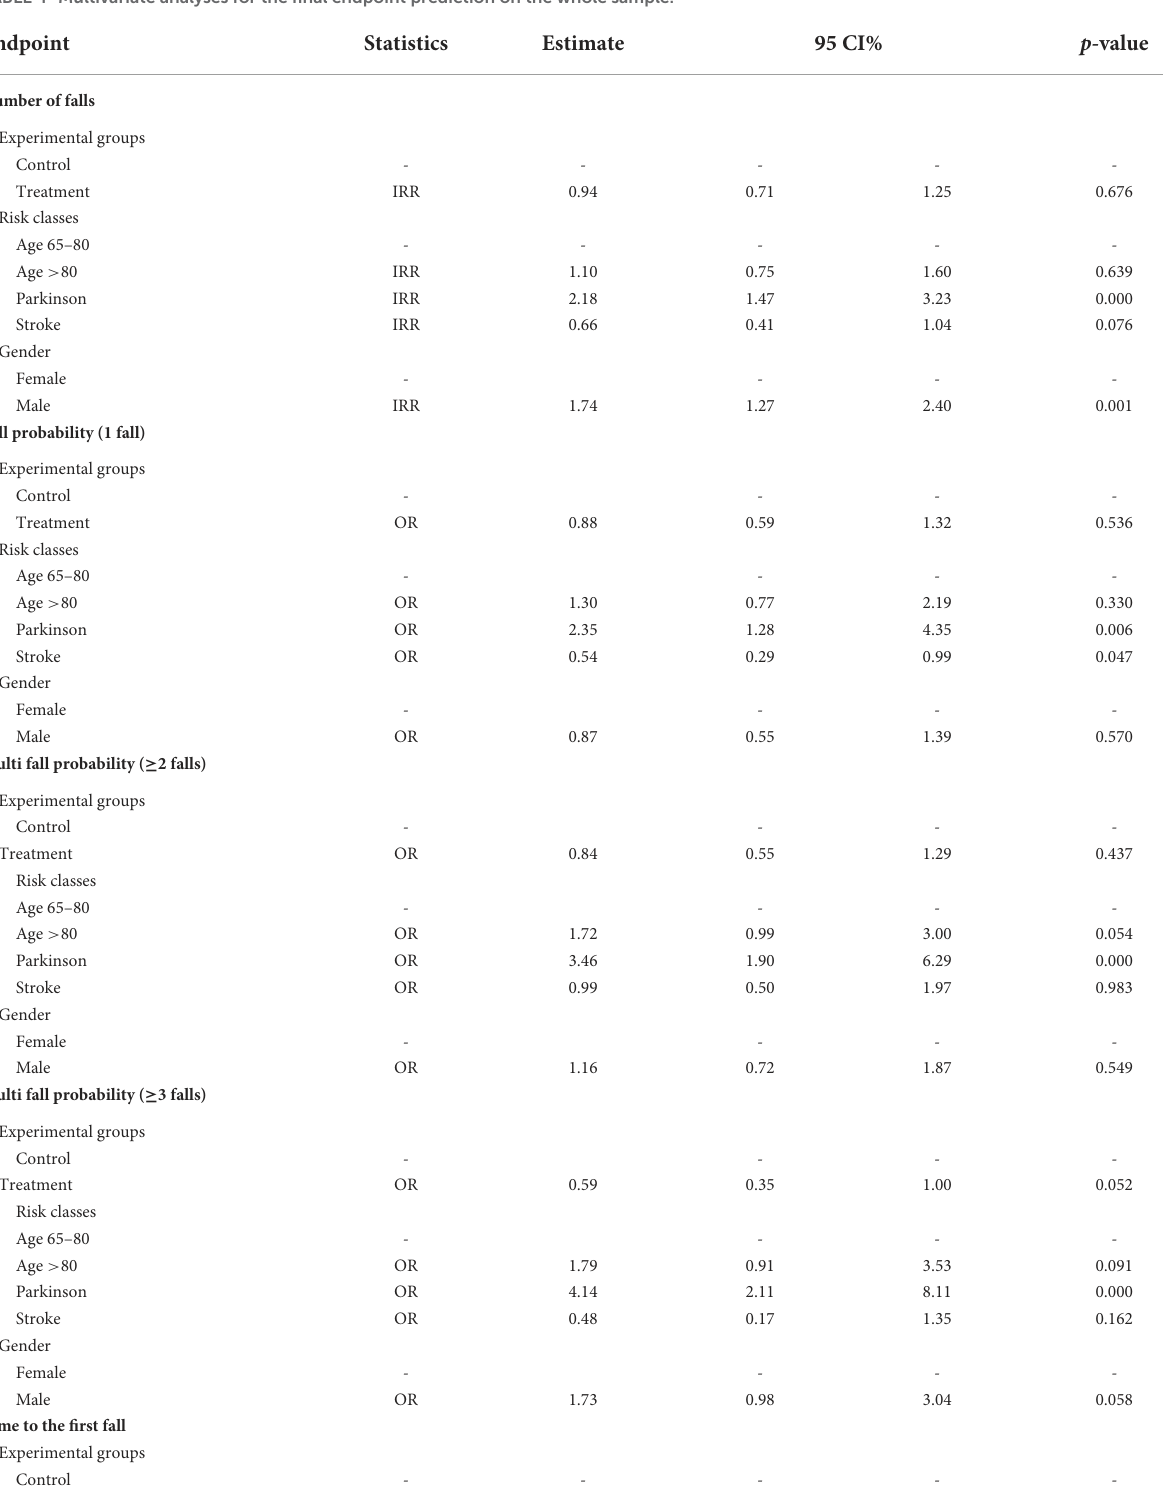
TABLE 4 Multivariate analyses for the final endpoint prediction on the whole